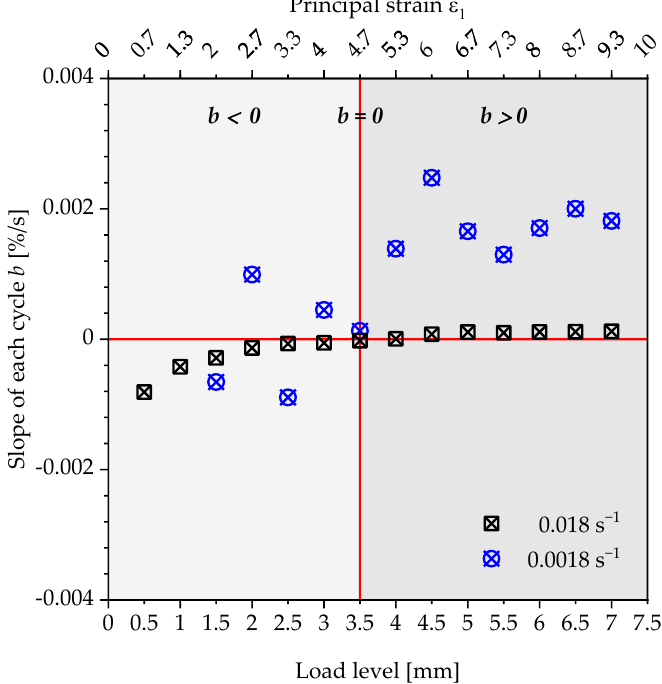
Figure 11. Plot of the slopes of the residual energy ratio curve within the specific load levels respective strain levels for the polyurethane system Neukadur ® under tensile load.